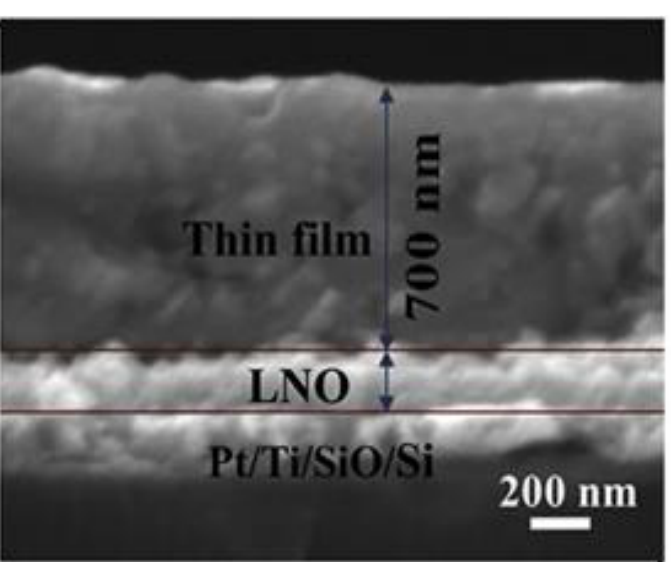
Figure 4. The cross-sectional SEM image of 0.5(Bi 0.5 Na 0.5 )TiO 3 -0.5Bi(Zn 0.5 Zr 0.5 )O 3 thin films [53]. Table 5. ESP of BNT-based thin films.